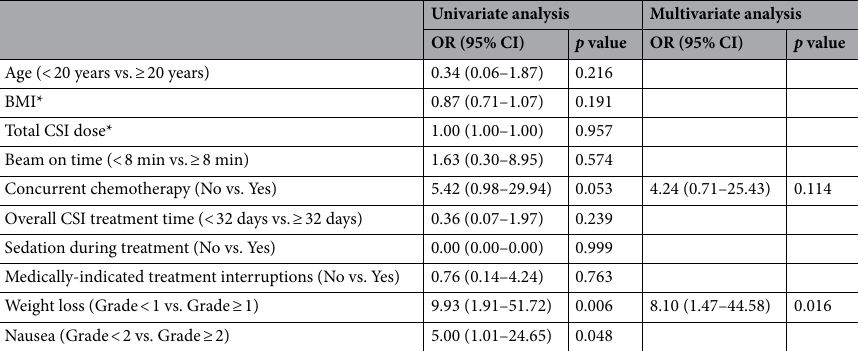
Table 2. Risk factors for significant intrafractional movement. OR odds ratio; CI confidence interval; BMI body-mass index; CSI craniospinal irradiation. *BMI and total CSI dose was treated as a continuous variable. The foreparts of the parentheses were set as the reference groups in the multivariable analysis.